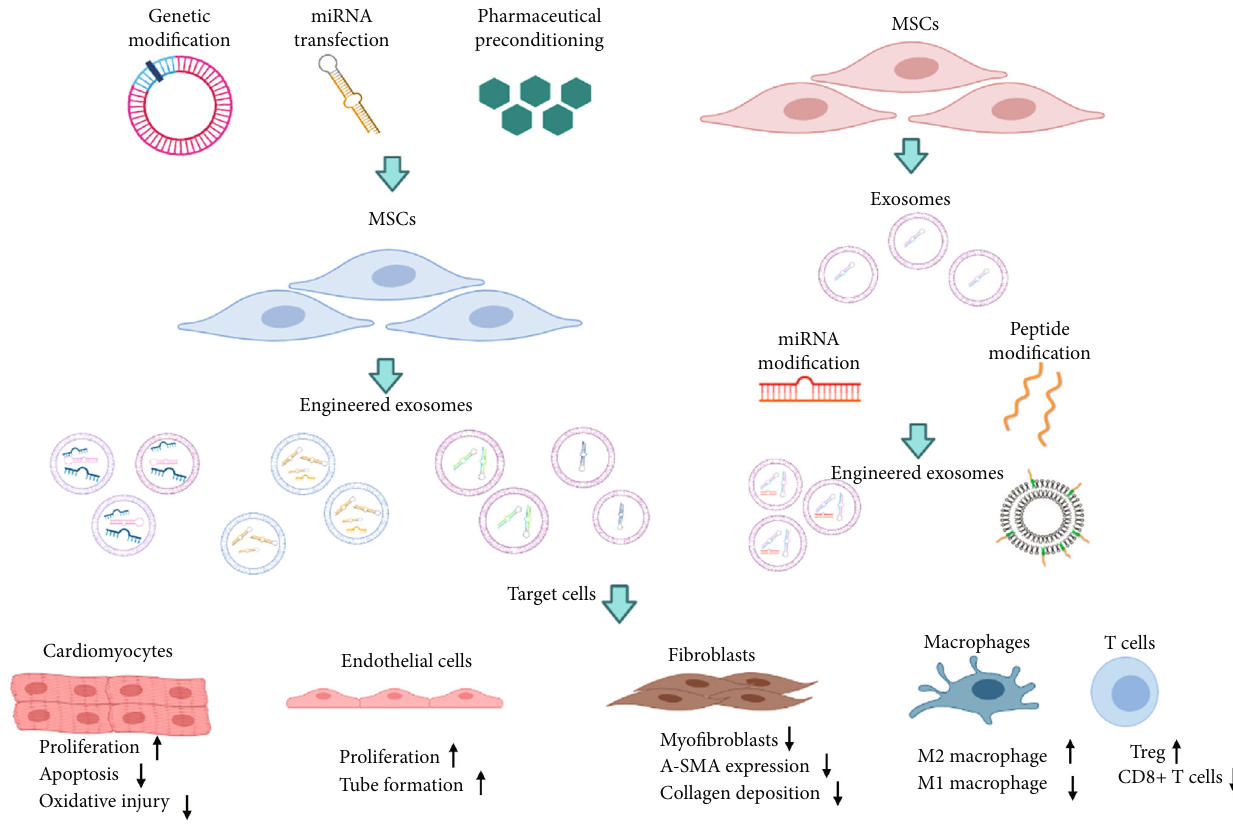
Figure 1: A variety of engineered modi fi cation methods of exosomes and their restorative function on di ff erent recipient cells were displayed in this fi